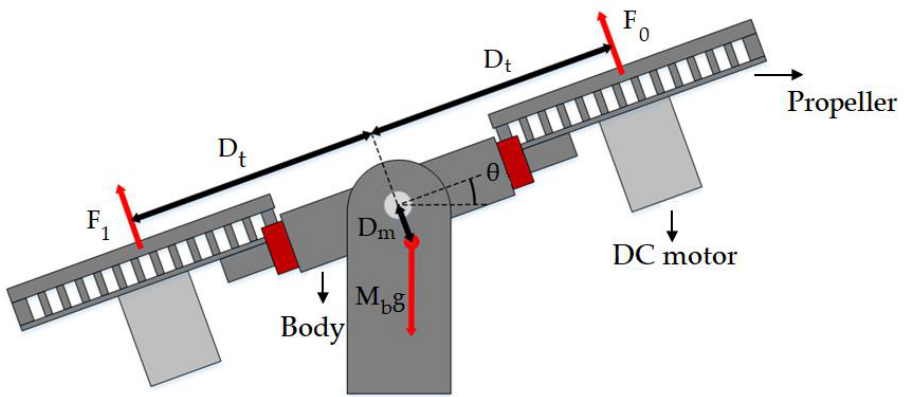
Figure 2. The one degree of freedom Aero 2 plant. Each propeller was driven by a DC motor, its supply voltage the input variable, and the output variable is the pitch angle . The plant model was obtained based on the DC motor and propeller models.